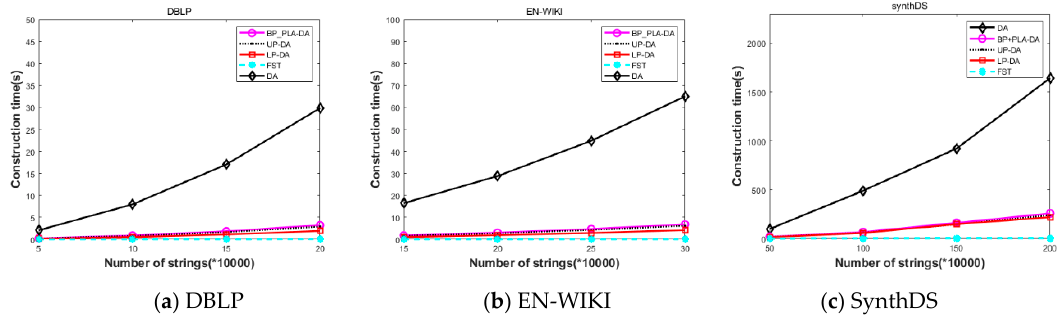
Figure 10. Construction times for different number of strings.